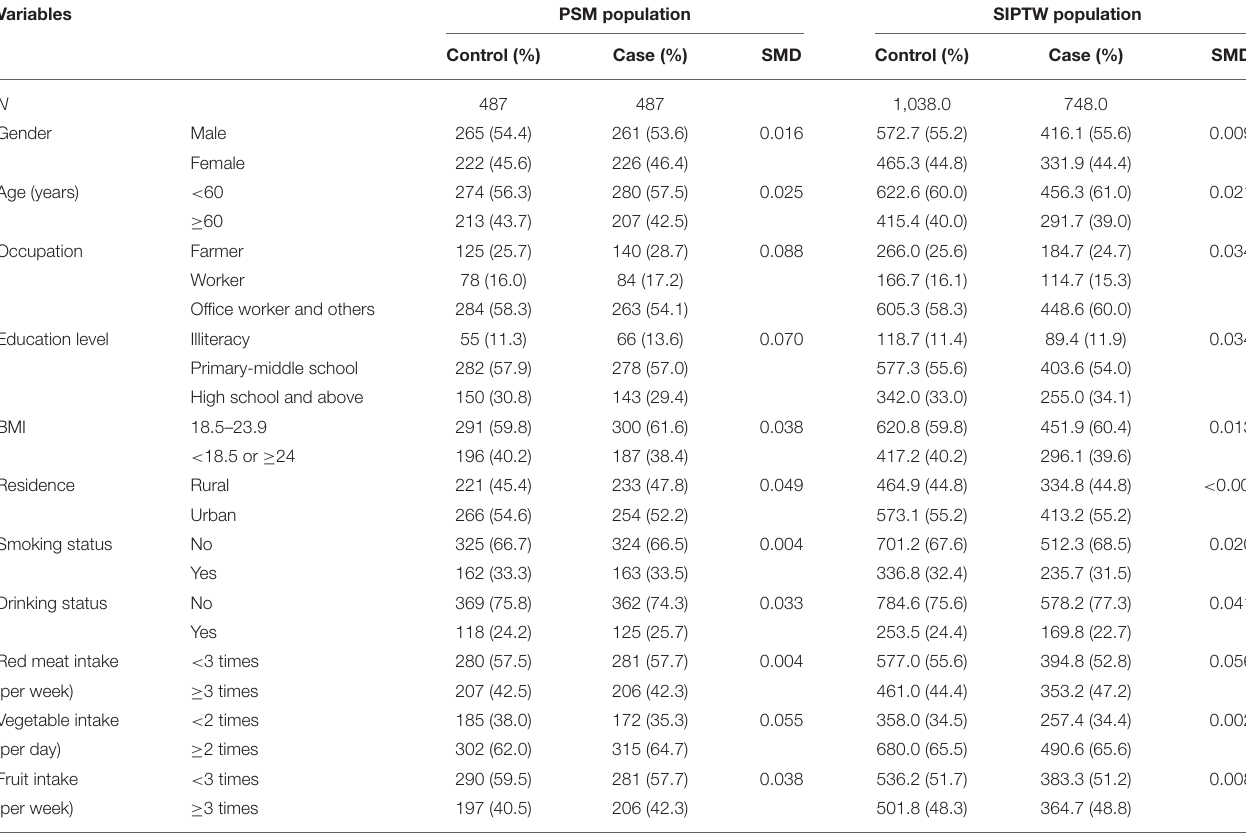
TABLE 1 | Baseline characteristics of case and control groups after propensity score